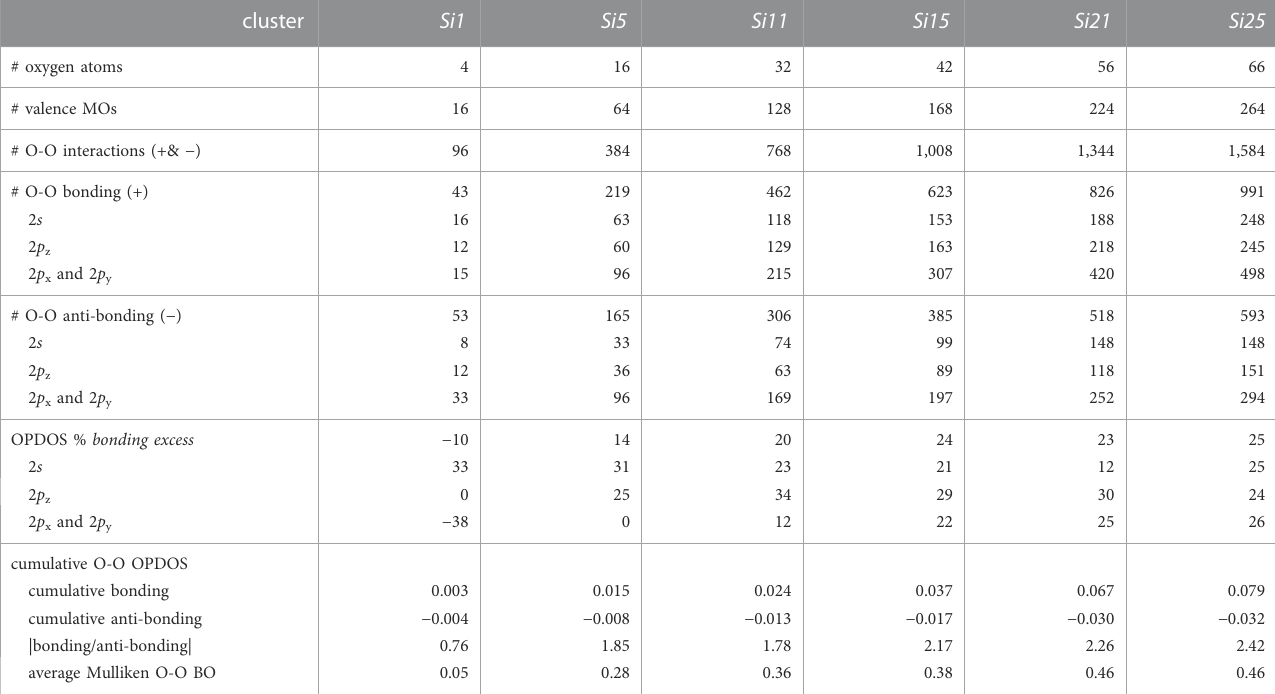
TABLE 2 Bonding vs anti-bonding interactions for the six central silicate oxygen-oxygen pairs according to overlap population density of states (OPDOS) analysis for silica clusters Si1 – Si25 .